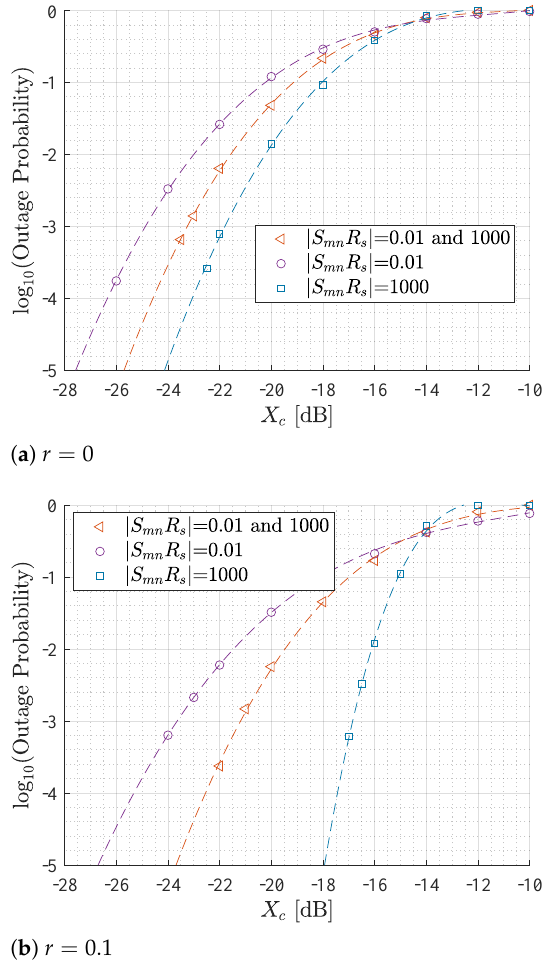
Figure 5. OP as a function of the ICXT level per interfering core, for L = 80 km, for two interfering cores, with the same SSRP and with different SSRPs, for ( a ) r = 0 and ( b ) r = 0.1. The dashed lines represent a cubic interpolation of log 10